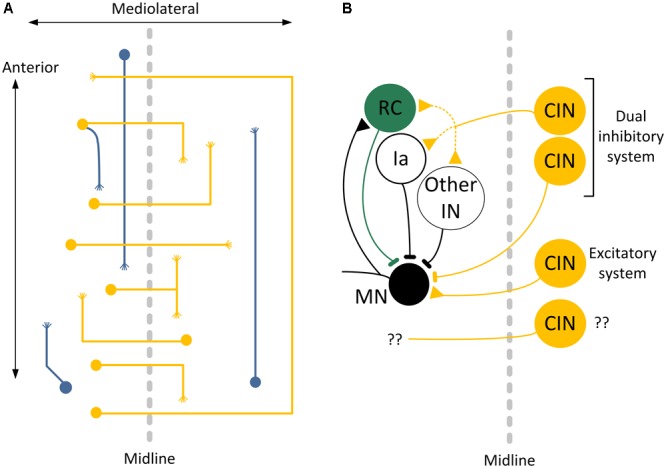
Commissural interneurons of the spinal cord. (A) Projections and terminations of short- and long range commissural interneurons (CINs). (B) CINs play an important role in the control of locomotion by projections to Renshaw cells, Ia inhibitory interneurons and other classes of inhibitory interneurons, and by direct monosynaptic excitation and inhibition to motoneurons. Adapted and modified from Quinlan and Kiehn (2007) and Chédotal (2014).